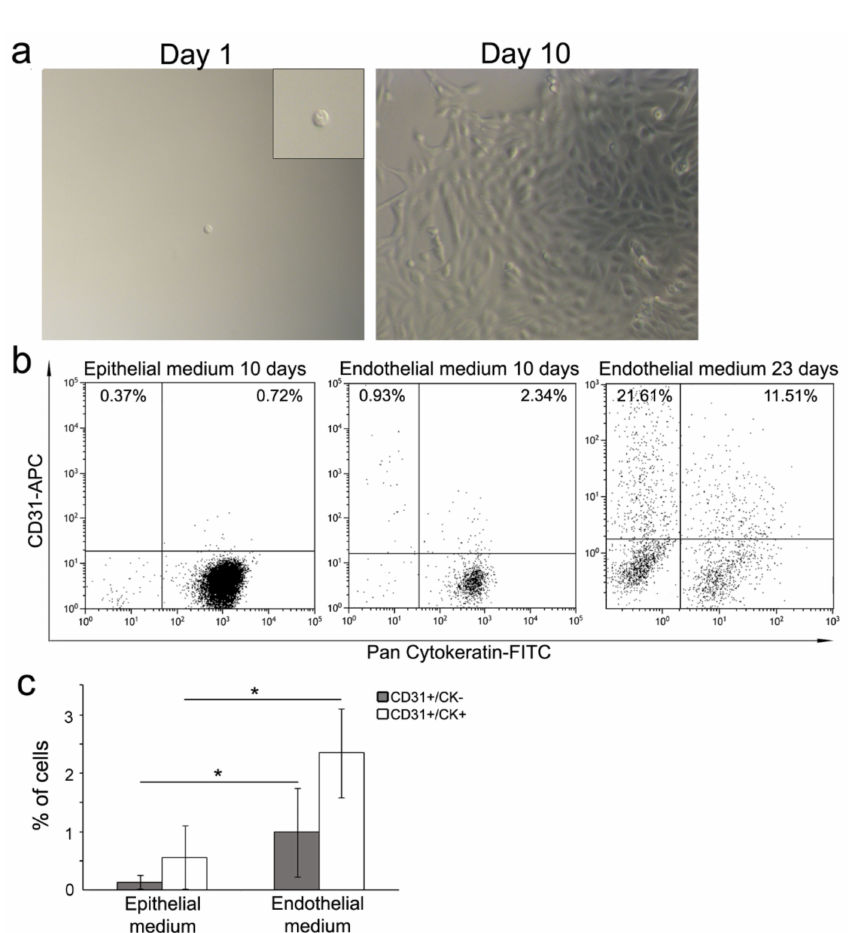
Figure 5. Single cell di ff erentiation. ( a ) Contrast-phase images of a representative single-sorted RSC (left panel) and the representative clone generated at day 10. Original magnification: 100 × . Insert: 2X digital zoom; ( b ) FACS analysis of two representative clones obtained from single RSC at ten days of culture in epithelial (left panel) and endothelial (middle panel) media. FACS analysis at 23 days of culture of one representative clone in endothelial medium (right panel). The CD31 and cytokeratin markers were evaluated; ( c ) graphic representation of CD31 +/ CK- and CD31 +/ CK + cell percentage within the clones obtained after 10 days of culture in specific media. Weighted mean ± SD is referred to four independent experiments of 10 clones grown in epithelial medium and 6 in endothelial